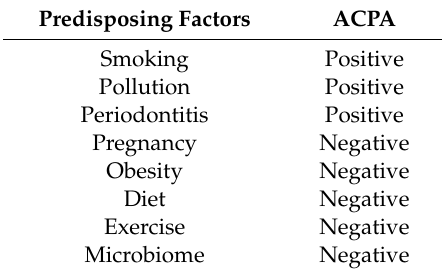
Table 1. Environmental factors associated with the development of rheumatoid arthritis (RA). Predisposing Factors ACPA Smoking